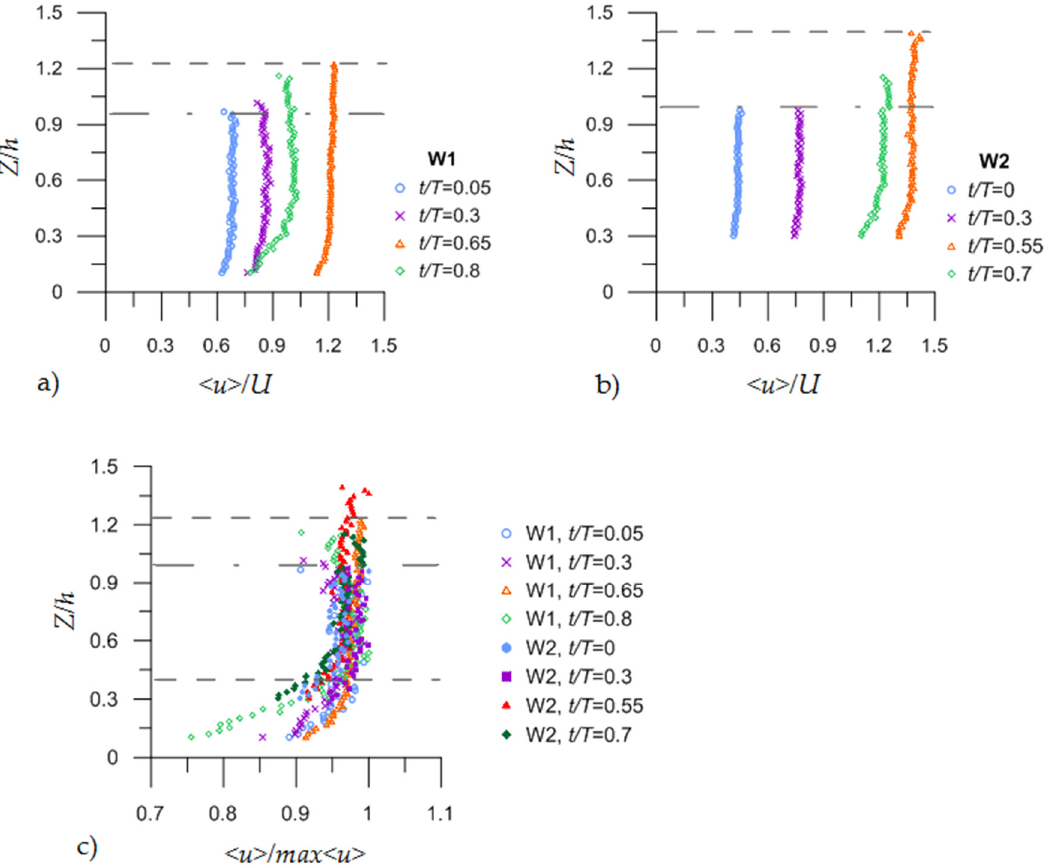
Figure 4. Top row: vertical profiles of the ensemble-averaged streamwise velocity < u >, normalized by U , measured at wave trough, ascending phase, crest, descending phase. Selected profile at X = 10.842 m and Y = 0.10 m. ( a ) Wave W1 and ( b ) wave W2. Bottom row ( c ): vertical profiles of <u> normalized by the maximum value of <u> detected for each profile.